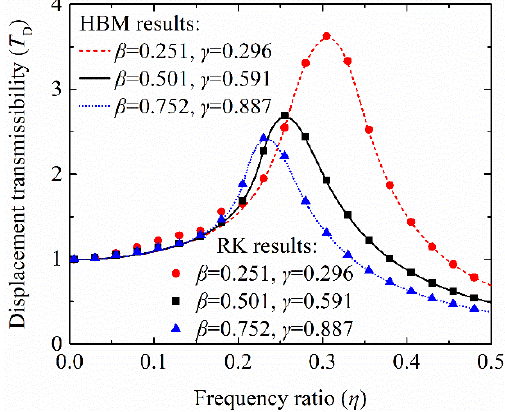
Figure 8. The frequency responses of the isolator with different values of β + γ . Table 3. The lowest peak transmissibility/resonant frequency and the corresponding excitation amplitudes with different values of β + γ . T pmin A b-pmin T